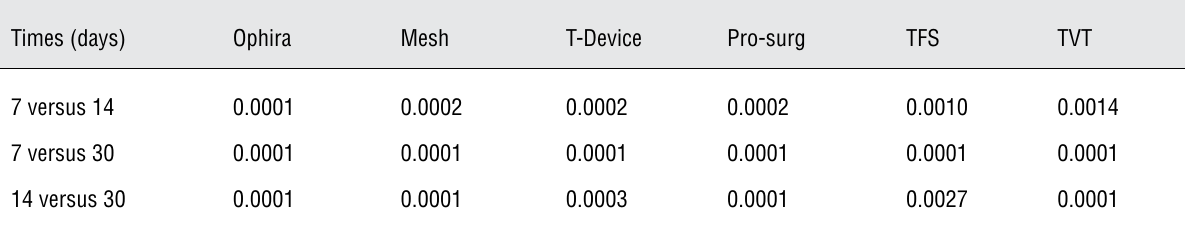
Table 3 - P-values for comparisons along time in each group (Contrast Test).